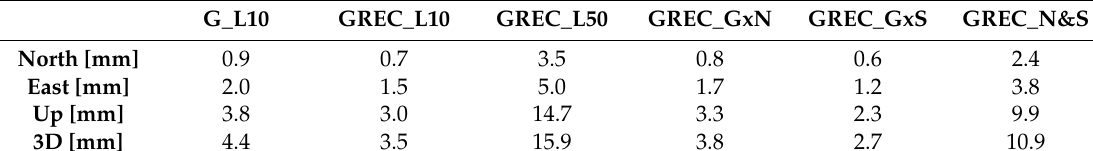
Table 5. Mean formal errors of coordinates for all stations during both test periods.